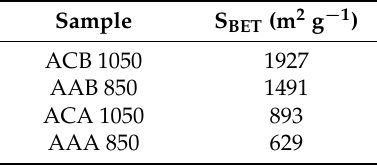
Table 1. BET area of carbon